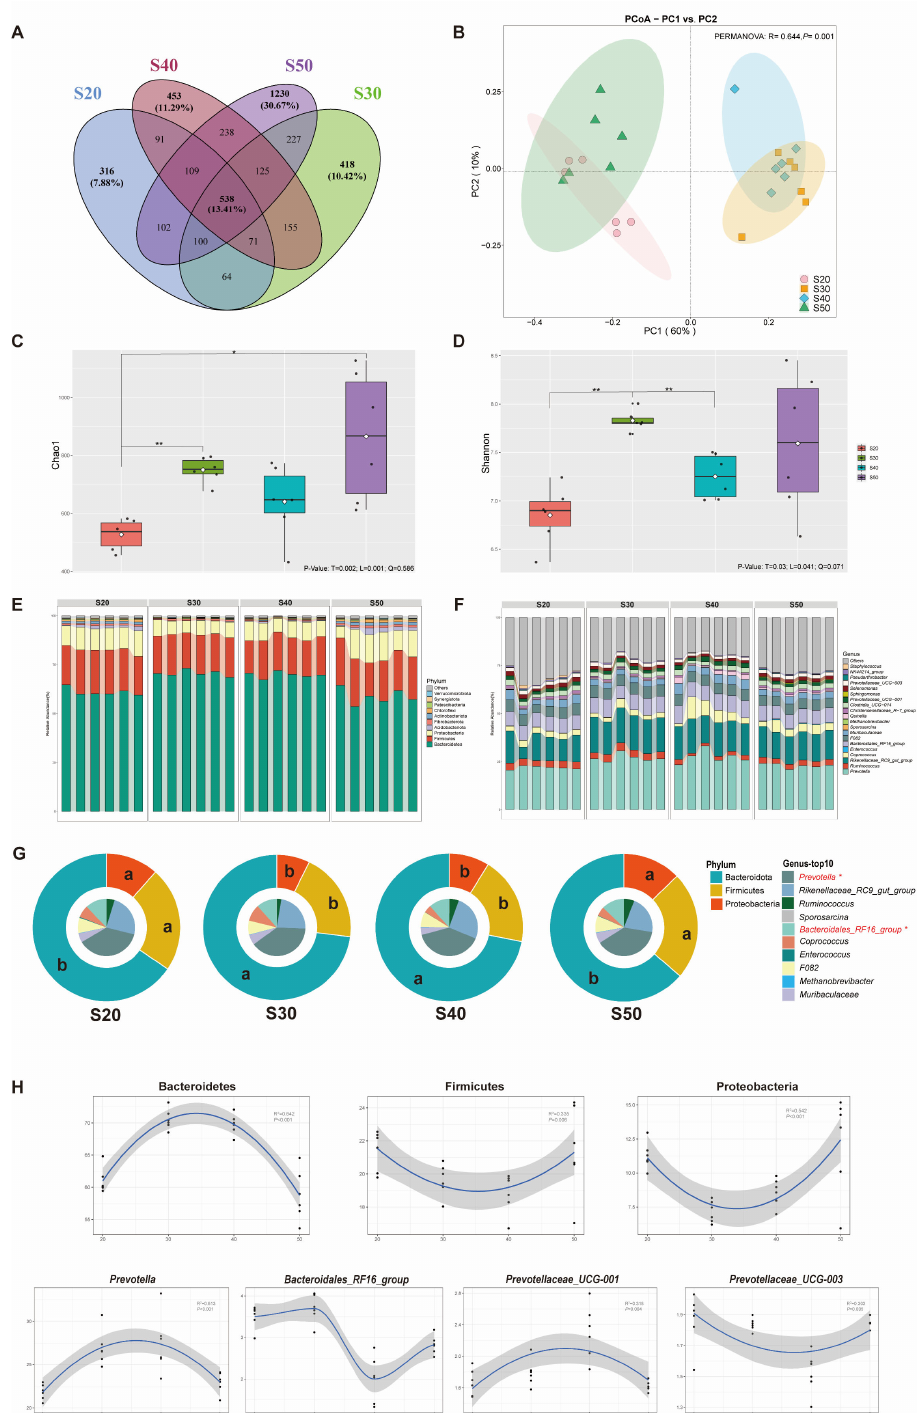
Figure 2. Bacterial diversity, taxonomic differences and changing tendency (n = 6). ( A ) Venn diagram showing shared and unique bacterial OTU numbers of four SP treatments. ( B ) Principal coordinate analysis (PCoA) of bacteria based on Bray–Curtis dissimilarity matrix of four SP treatments. ( C , D ) Alpha diversity of bacteria in four SP treatments, * represents p < 0.05 and ** represents p < 0.01. Bacterial compositions of four SP treatments at the phylum ( E ) and genus ( F ) levels. ( G ) Pie chart of differential microbes in four SP treatments, different letters indicate significant difference of SP treatments at p < 0.05. ( H ) The trend of differential microbes changing with SP. Treatments: S20, S30, S40 and S50 are ~14% CP, SP proportion (% of CP) 20, 30, 40 and 50,